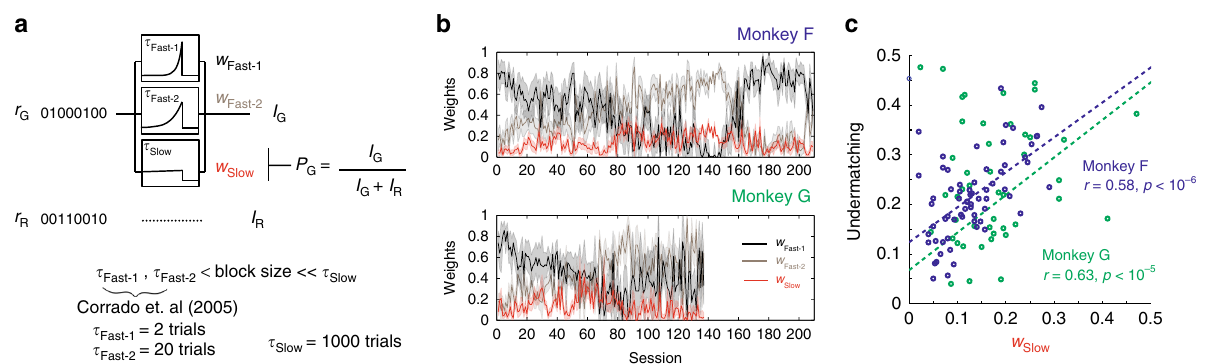
Fig. 5 Fitting the multi-timescale model of Fig. 2 to the data. a A model with three timescales ( τ Fast − 1 = 2 trials, τ Fast − 2 = 20 trials, and τ Slow = 1000 trials) is fi tted to the data by tuning the weights w w w Fast − 1 (black), Fast − 2 (brown), and Slow (red) of the different integrators for each session independently ( w + w = 1). b The weights of different timescales change over consecutive experimental sessions. The short timescales are dominant in early Fast − 2 Slow sessions, but the longer timescale becomes progressively more in fl uential. The opposite trend is observed around session 160 of monkey F, probably due to the shortening of experimental sessions and longer inter-experimental-intervals (see Supplementary Figure 16 for more details). c Deviation from the matching law is correlated with the weight of the reward integration on a long timescale. Undermatching, computed over the last 50 trials of each block to ignore transients, is plotted against the fi tted value of w Slow , the weight of the longest reward integration timescale. Both monkeys show signi fi cant correlations between undermatching (1 − slope) and w Slow . We found, however, this model-based analysis inconclusive, as the correlation is expected from the model structure (please see the